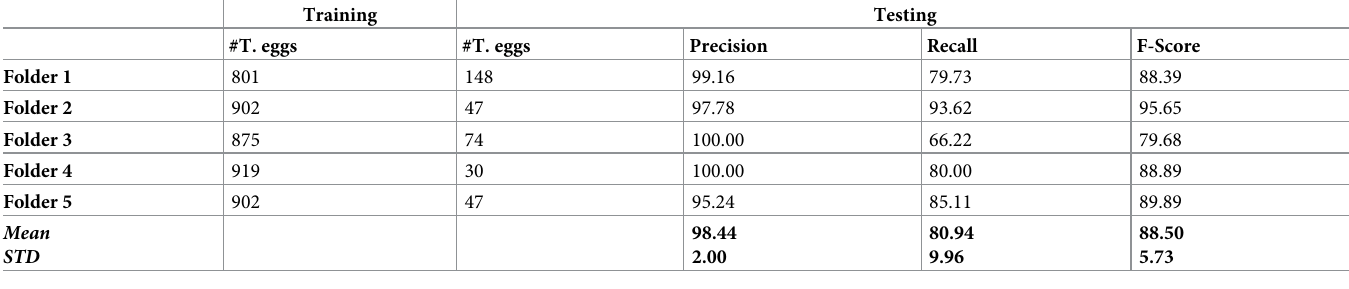
Table 2. Detailed performance of the proposed methodology for the detection of Trichuris spp. using a leave-one-one cross-validation scheme at the patient level.